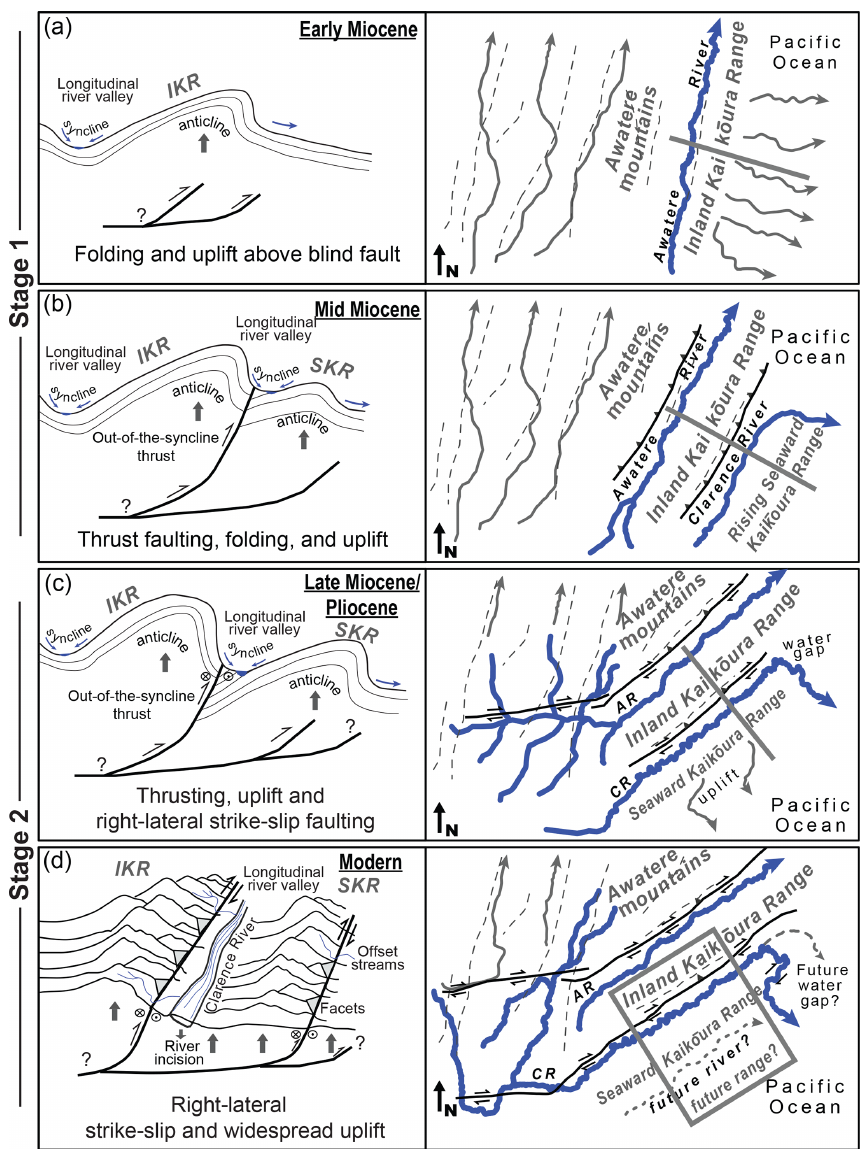
Figure 6. Schematic cartoon of Marlborough Fault System landscape evolution through time. Left panel shows cross-sectional view of the Kaik ¯ oura domain, and right panel shows map view of landscape, expanded to include both the Kaik ¯ oura and Inland Marlborough domains. Approximate location of left-panel cross section shown with gray line (a–c) or box (d) in right panel. Right panel depicts active faults in black and inactive faults in gray and the approximate rotation of the faults and landscape from Randall et al. (2011). IKR – Inland Kaik ¯ oura Range, SKR – Seaward Kaik ¯ oura Range, AR – Awatere River, and CR – Clarence River. See Sect. 5.2 of text for a description of conceptual